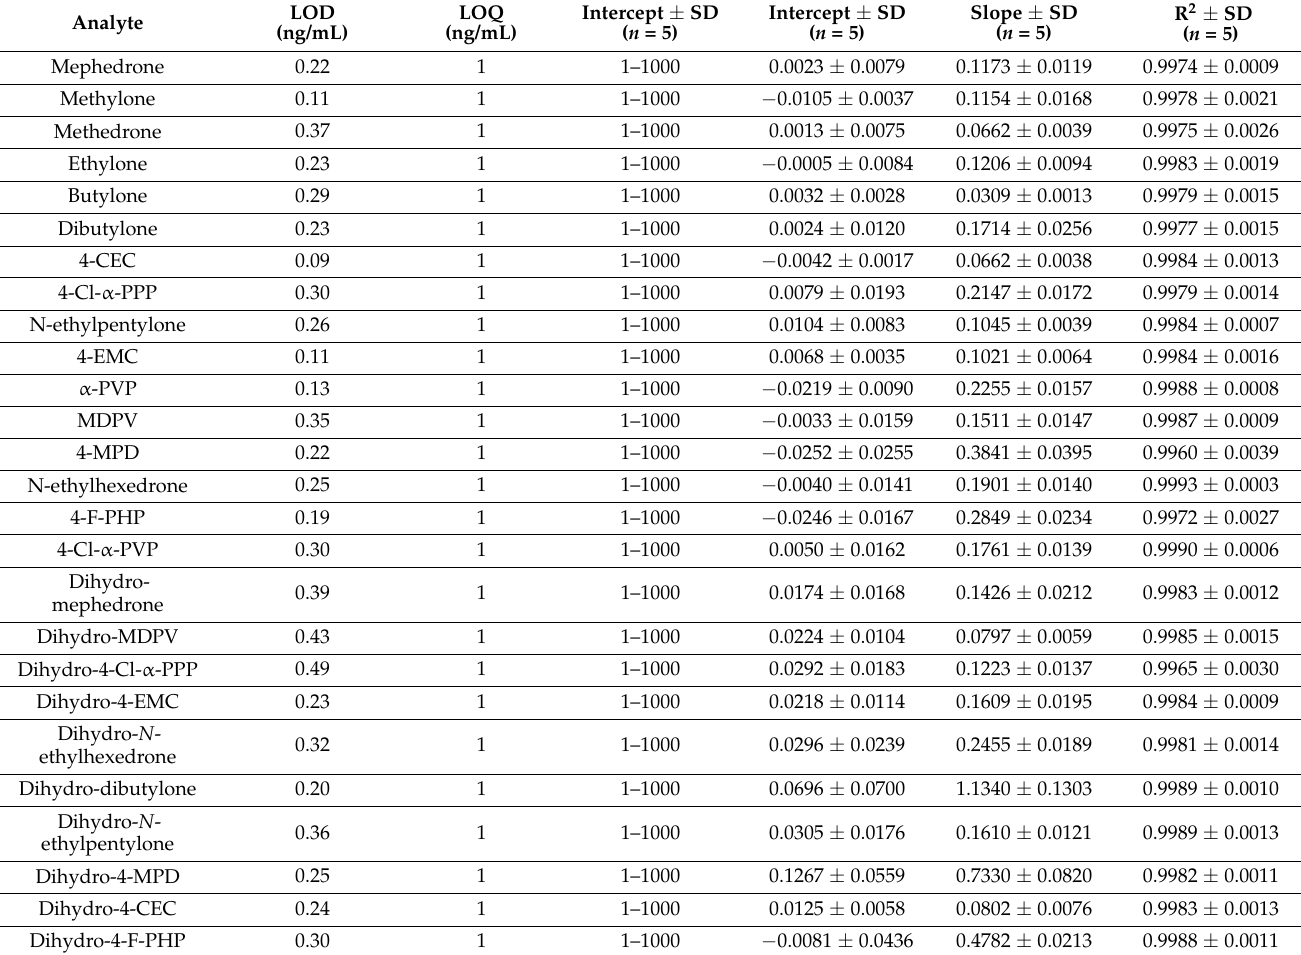
Table 2. Calibration parameters, limit of detection and limit of quantification for all analytes in urine samples.